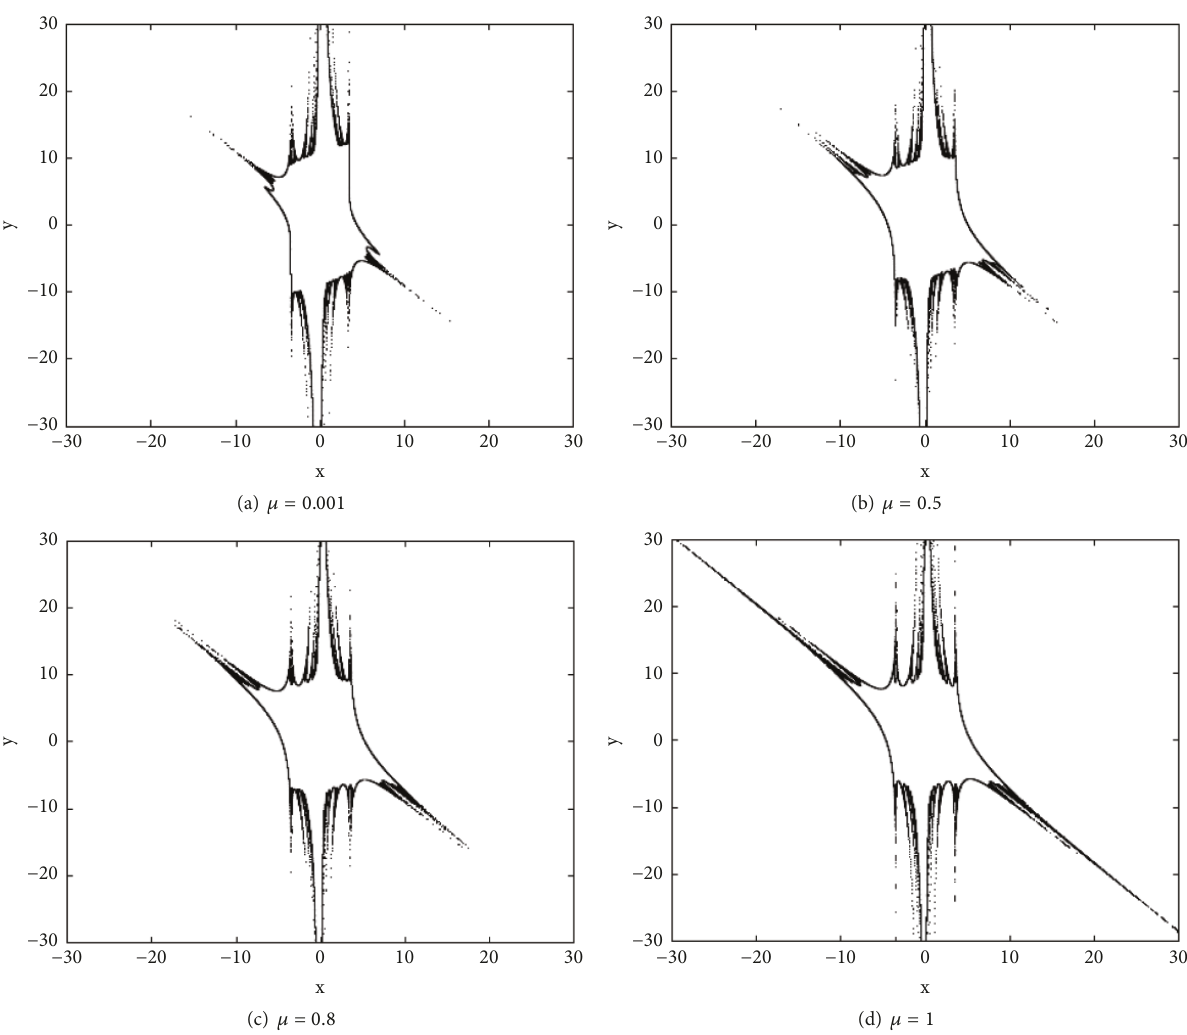
Figure 2: Julia sets of the controlled system (12) when ( a ) 𝜇 = 0.001 ; ( b ) 𝜇 = 0.5 ; ( c ) 𝜇 = 0.8 ; ( d ) 𝜇 = 1 .